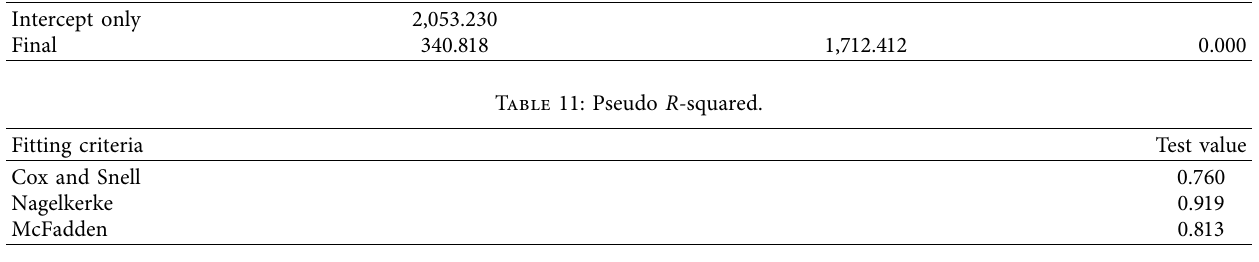
Table 12: Estimations of the MNL model fused with social economic variables.